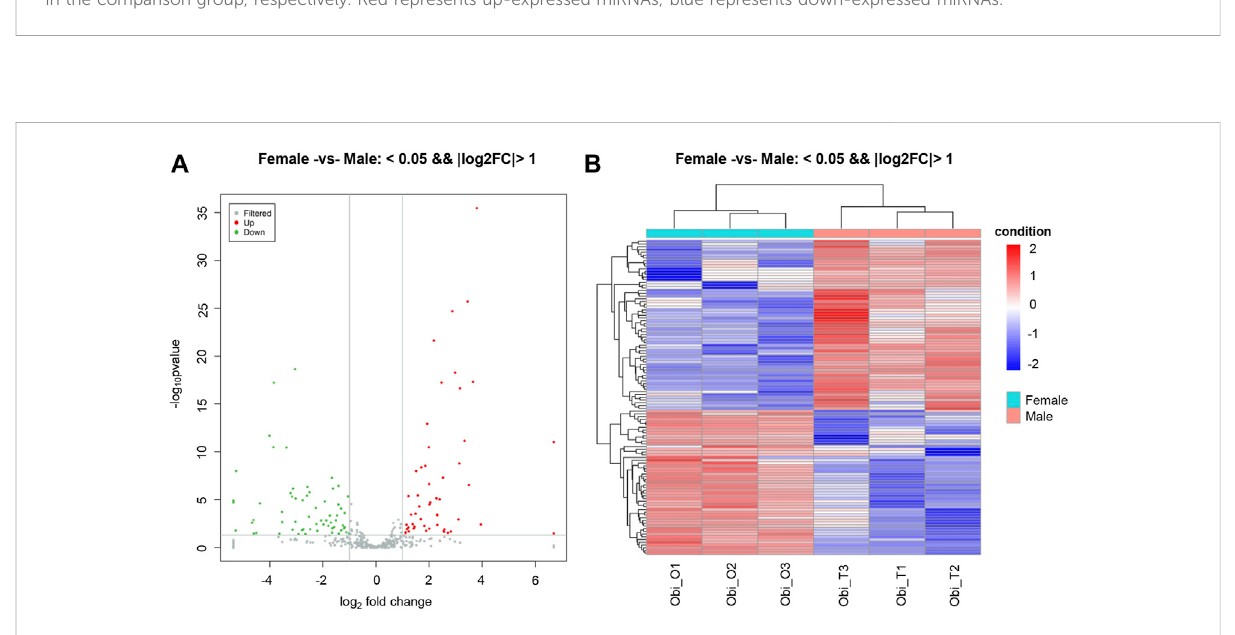
FIGURE 2 DistributionofdifferentiallyexpressedmiRNAs(DEMs). (A) VolcanoplotofDEMsingonadsof O.bidens .The X and Y axesshowexpressionlevels of miRNAs in ovary and testis, respectively. Red dots represent up-expressed miRNAs; green dots represent down-expressed miRNAs. (B) Hierarchicalclustering ofDEMsdifferentiallyexpressedbetween ovaryandtestis.Theheat mapwasdrawnwithlog10NEofeachmiRNA.Blue,white and red represent low, middle and high NE, respectively. NE: normalized